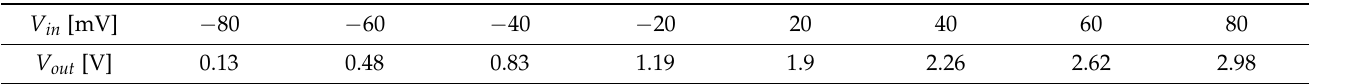
Table 3. Experimentally determined voltage at the output of the circuit for adjusting the voltage generated on the